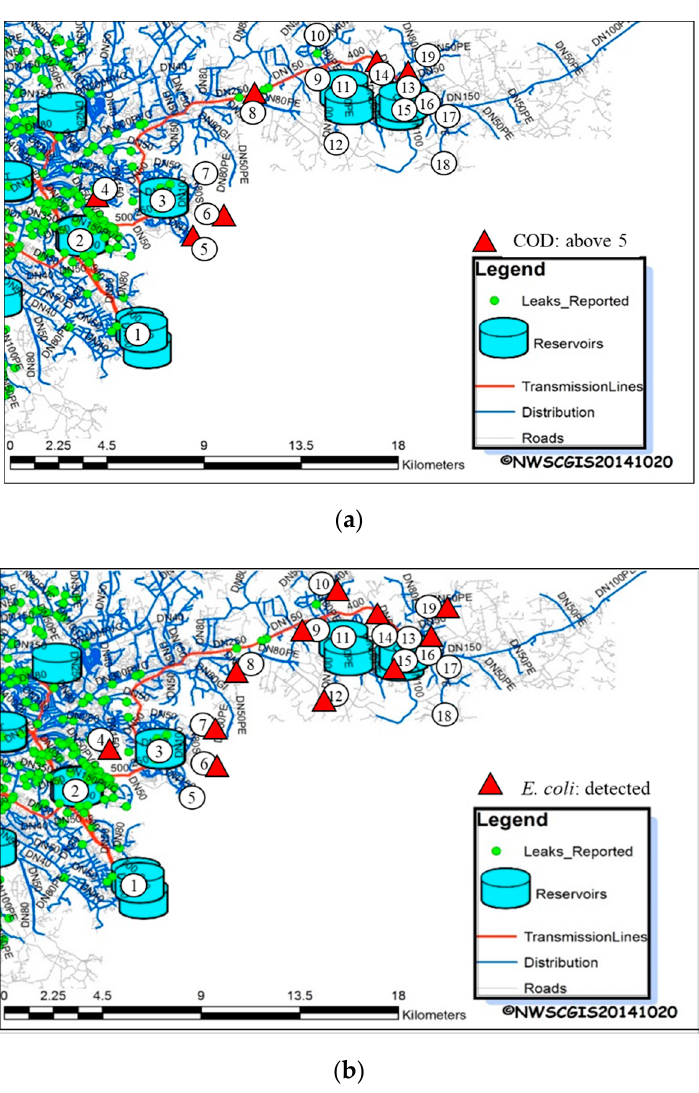
Figure 9. Kampala water distribution system and pipeline from Ggaba II to Mukono with leak occurrences (green circles) overlaid with E. coli measurements ( a ) and COD measurements ( b ). The name of the numbered sites is shown on the Table 1.